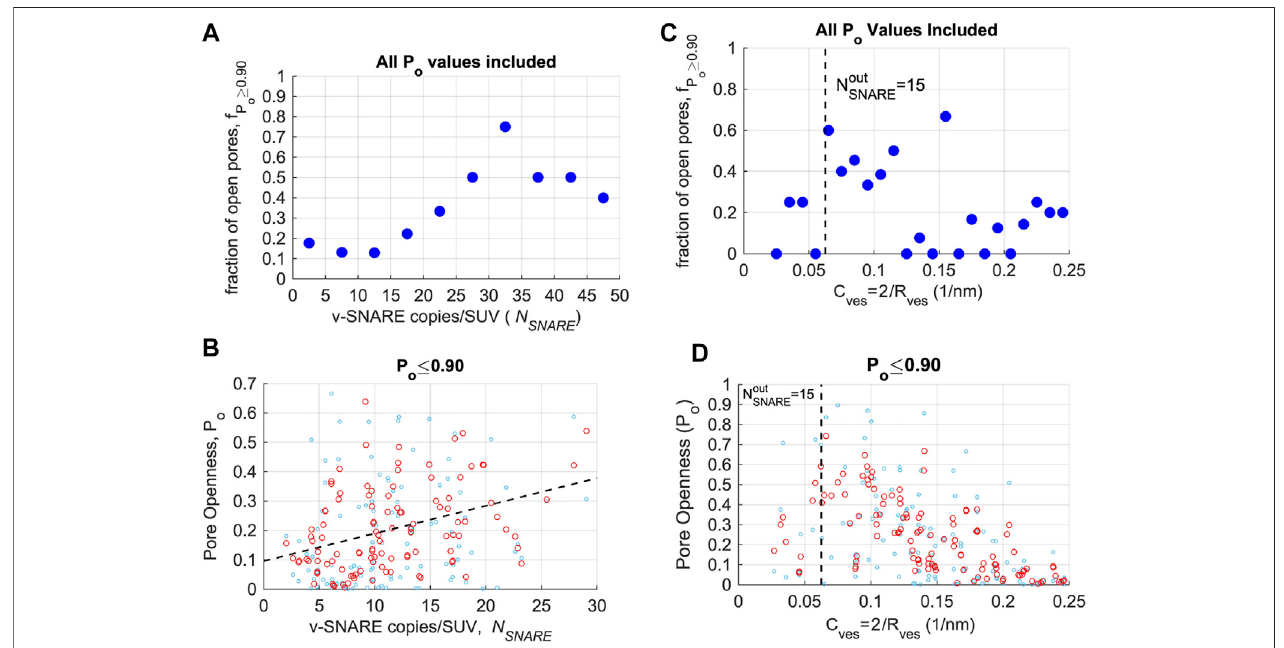
FIGURE 4 | Pore openness as a function of SNARE copies per liposome or vesicle curvature. (A) The fraction f P of open pores ( P o ≥ 0 . 90 ) , as a function of o ≥ 0 . 90 average v-SNARE copies per SUV, N SNARE . The fraction increases up to N SNARE ≈ 30, to reach ∼ 0.5. (B) Pore openness for fl ickering pores ( P o < 0 . 90 ) , as a function of N SNARE . The red circles are original data points (light blue) smoothed with a moving average fi lter with span (cid:1) 5. The dashed line is a linear fi t to the smoothed data with slope 0.0094 (95% con fi dence interval (cid:1) 0.0051 – 0.0138, R 2 (cid:1) 0 . 15). Note that because v-SNAREs are reconstituted with random orientation, only ∼ 1/2 would face outsideand contribute tofusion. (C) Thereisno clearcorrelationbetweenthefraction f P ofopenpores ( P o ≥ 0 . 90 ) and totalmembranecurvature, C (cid:1) 2/ R ves . o ≥ 0 . 90 (D) Pore openness for fl ickering pores ( P o < 0 . 90), as a function of membrane curvature. For fl ickering pores ( P o < 0 . 90 ) , P o decreases with increasing curvature for vesicle curvatures that correspond to N out SNARE ≈ 15 (indicated by a vertical dashed line) or smaller. Symbols represent original and smoothed data points as in (B) . For (A,C) , 164 events were analyzed. For (B,D) , 128 events were